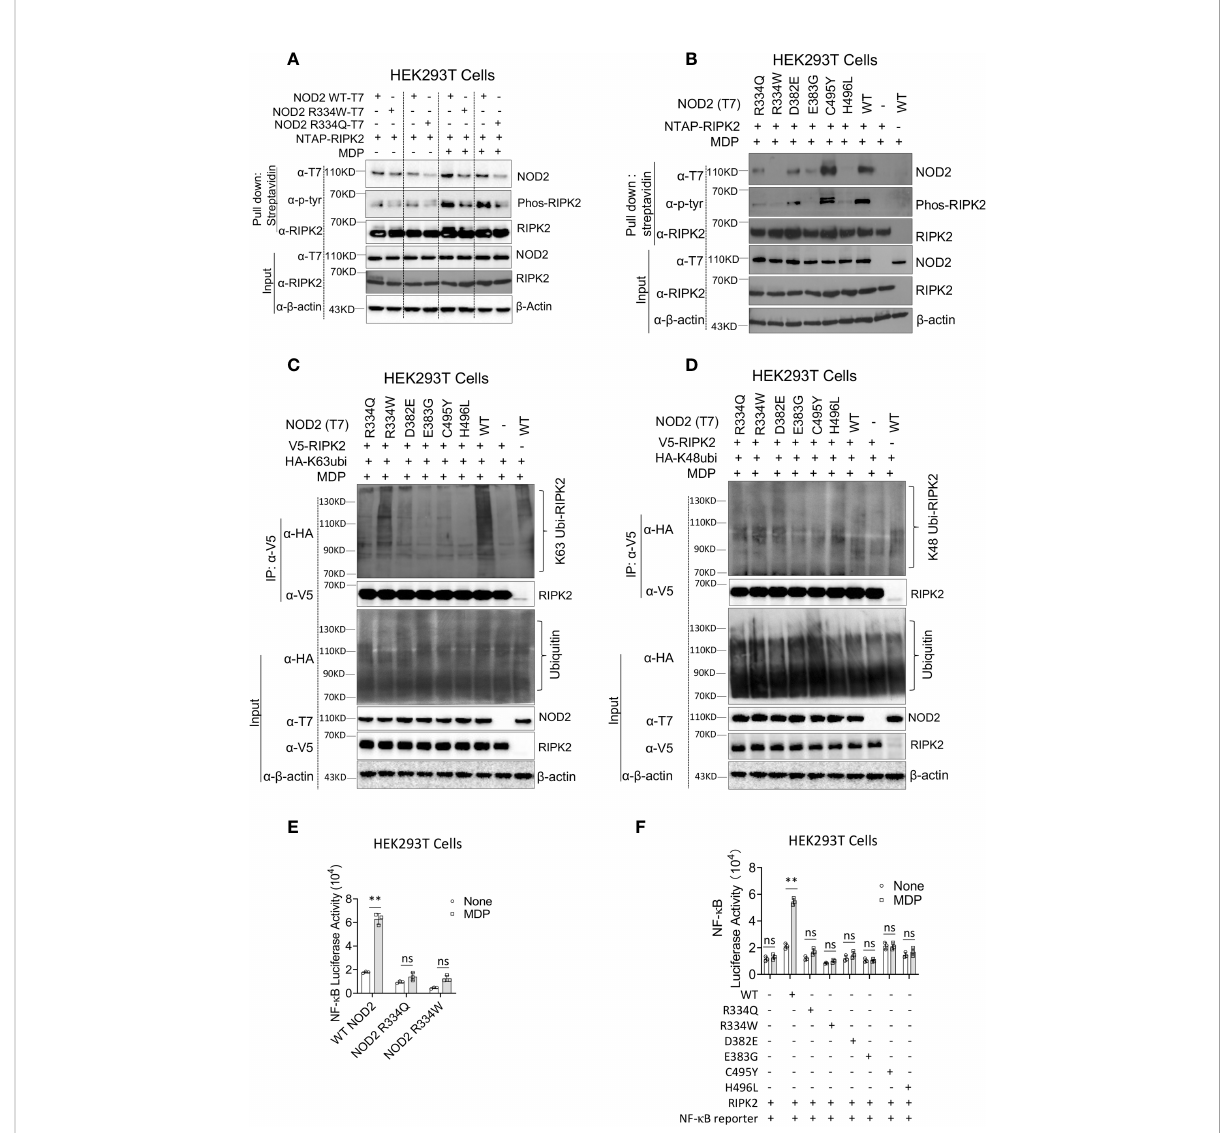
FIGURE 2 The BS-NOD2 Mutation Causes Reduced NOD2-Induced Interaction with RIPK2, Reduced RIPK2 Activation and Reduced NF- k B Activation. (A) HEK293T cells were transfected with constructs expressing T7-tagged wildtype or BS-NOD2 mutations (R334Q or R334W) and NTAP-tagged RIPK2; 24 hours later, the cells were incubated with or without MDP (10 m g/ml) for 6 hours after which the cells were lysed and subjected to pull-down assay for detecting NOD2-RIPK2 interaction and RIPK2 phosphorylation. (B) HEK293T cells were transfected with constructs expressing T7-tagged human wildtype NOD2 or with one of multiple constructs expressing various NOD2 mutations associated with Blau syndrome; in addition, the cells were transfected with NTAP-tagged RIPK2; 24 hours later, the cells were stimulated with MDP (10 m g/ml) for 6 hours after which the cells were lysed and the cell lysates obtained were subjected to pull-down assay using streptavidin beads and Western blotting for detection of NOD2-RIPK2 interaction and RIPK2 phosphorylation. (C, D) HEK293T cells were transfected with constructs expressing wildtype NOD2 or one of multiple Blau syndrome constructs expressing various NOD2 mutations; in addition, the cells were transfected with constructs expressing V5-tagged RIPK2 and HA- tagged K63-only ubiquitin ( C , other lysine sites mutated to alanine) or HA-tagged K48-only ubiquitin ( D , other lysine sites mutated to alanine); 24 hours later, the cells were stimulated with MDP (10 m g/ml) for 6 hours and then lysed; fi nally, the cell lysates were subjected to IP with agarose beads conjugated with anti-V5 antibody and Western blotting for detection of RIPK2 polyubiquitination. All data are representative fi gures from two independent experiments. (E) HEK293T cells were transfected with constructs expressing wildtype NOD2 or constructs bearing the indicated Blau mutations as well as an NF- k B reporter construct; 24 hours later, the cells were incubated with or without MDP (10 m g/ml) for 6 hours and were then lysed; fi nally, the lysates were subjected to luciferase assay for detection of NF- k B activation. (F) HEK293T cells were transfected with constructs expressing one of multiple constructs expressing Blau syndrome NOD2 mutations, RIPK2 and NF- k B reporter; 24 hours later, the cells were incubated with or without MDP (10 m g/ml) for 6 hours and were then lysed; fi nally, the lysates were subjected to luciferase assay for detection of NF- k B activation. Studies in (A, B) were conducted with three biological replicates for each sample. Data were analyzed using a two-way ANOVA with Tukey ’ s multiple comparisons and are displayed as mean ± SEM; **p<0.01. ns, not signi fi